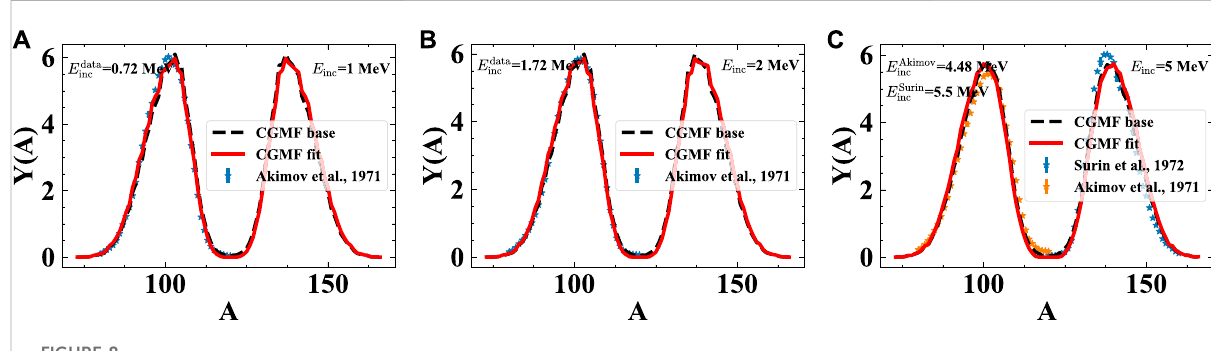
FIGURE 8 Comparison of the baseline CGMF calculation (black dashed), evaluated CGMF calculation (red solid) and experimental data ( fi lled symbols) for the pre-neutron emission mass distributions, Y ( A ), at incident neutron energies of 1, 2, and 5 MeV.